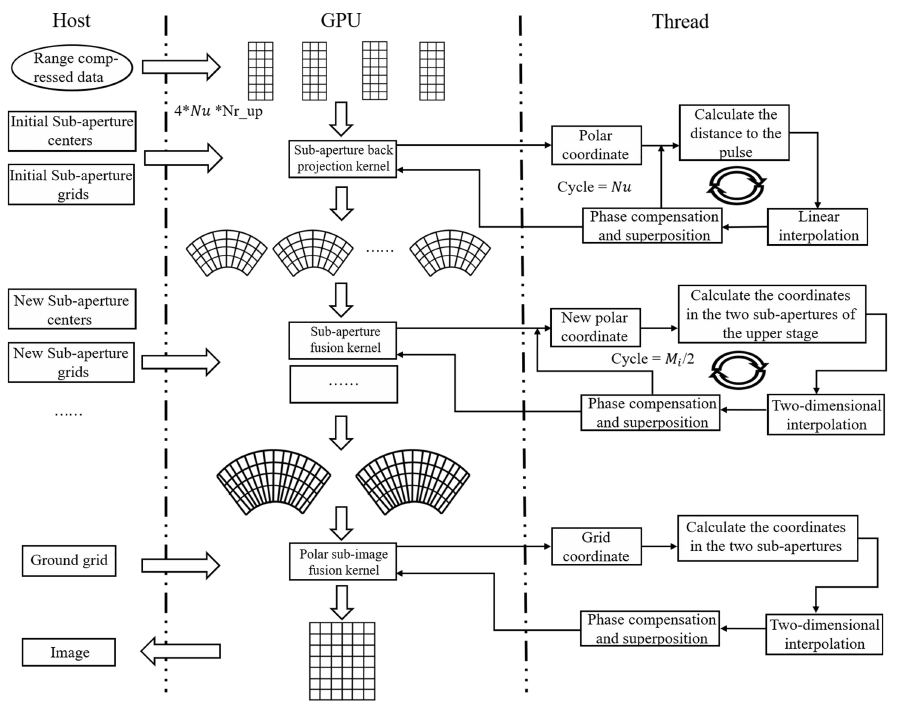
Figure 6. Parallel FFBP